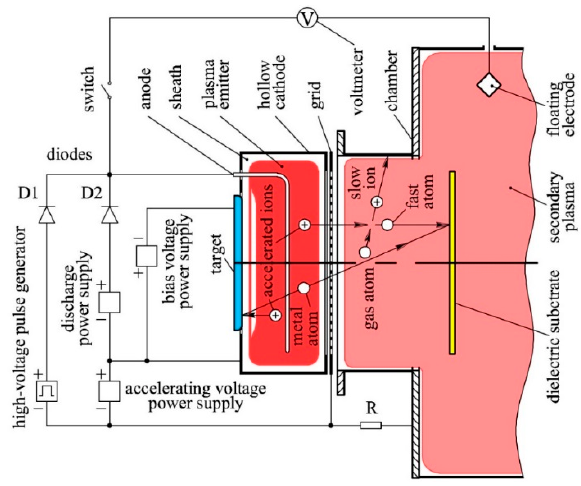
Figure 1. Schematic of the experimental setup.